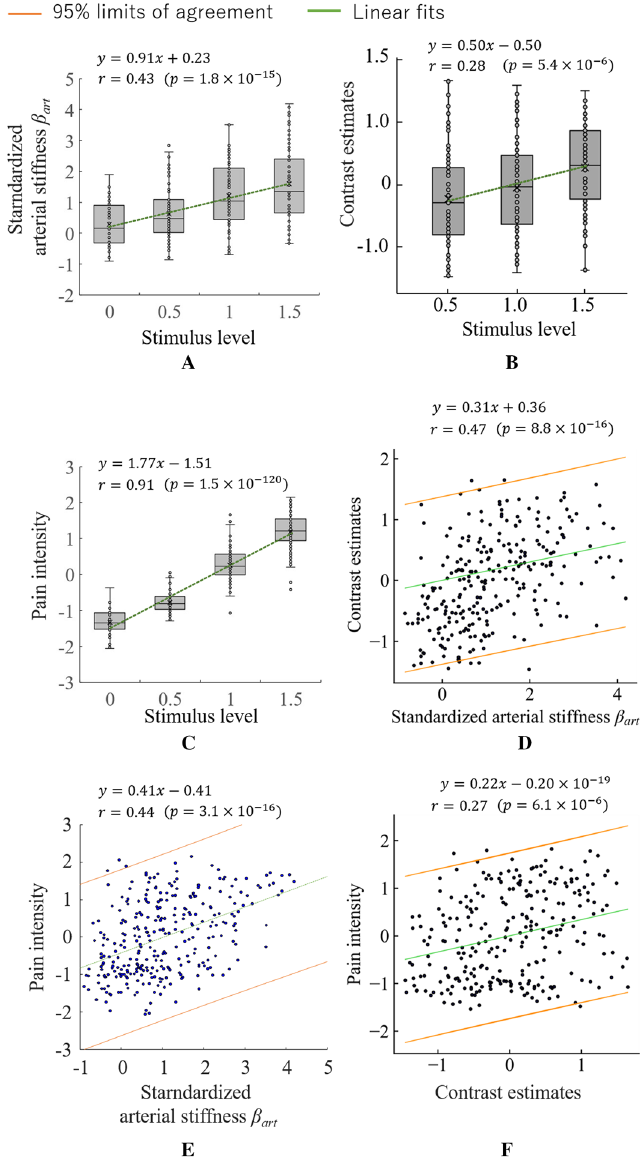
Figure 8. Correlations between standardised stimulation level, peripheral arterial stiffness parameter ( β art ), contrast estimates averaged over all pain matrix-related areas, and self-reported pain intensity (VAS